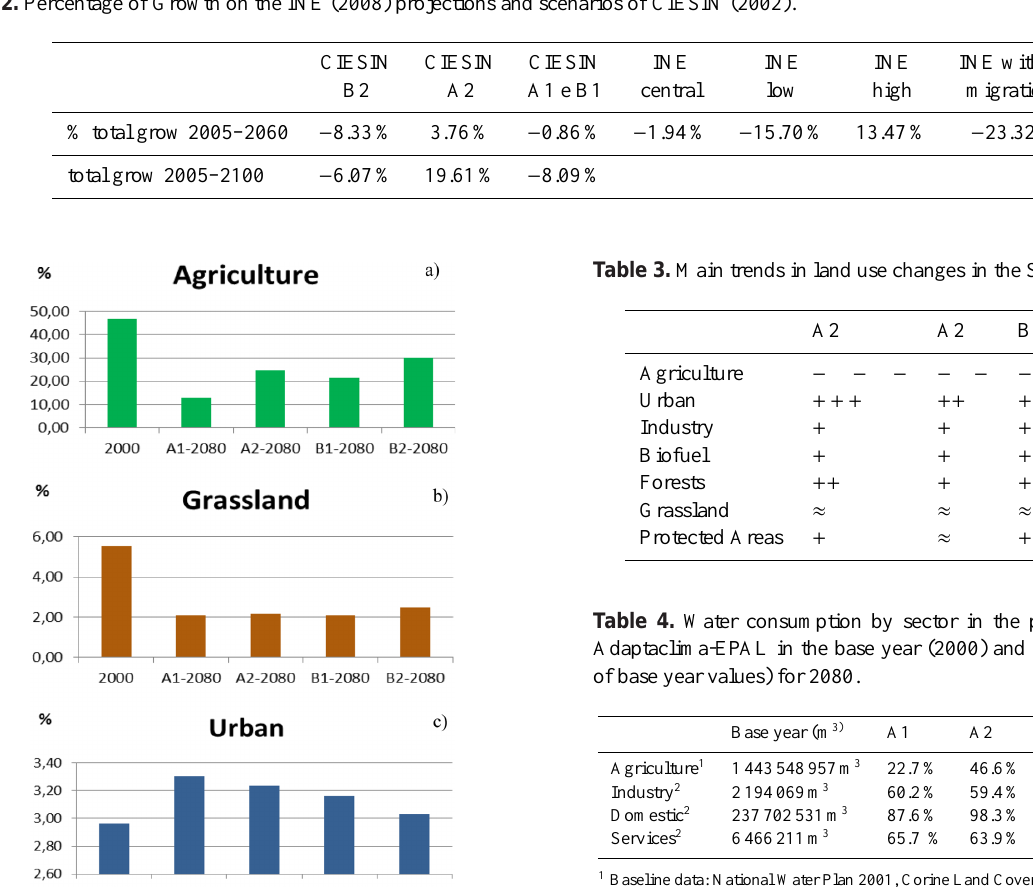
Table 2. Percentage of Growth on the INE (2008) projections and scenarios of CIESIN (2002).